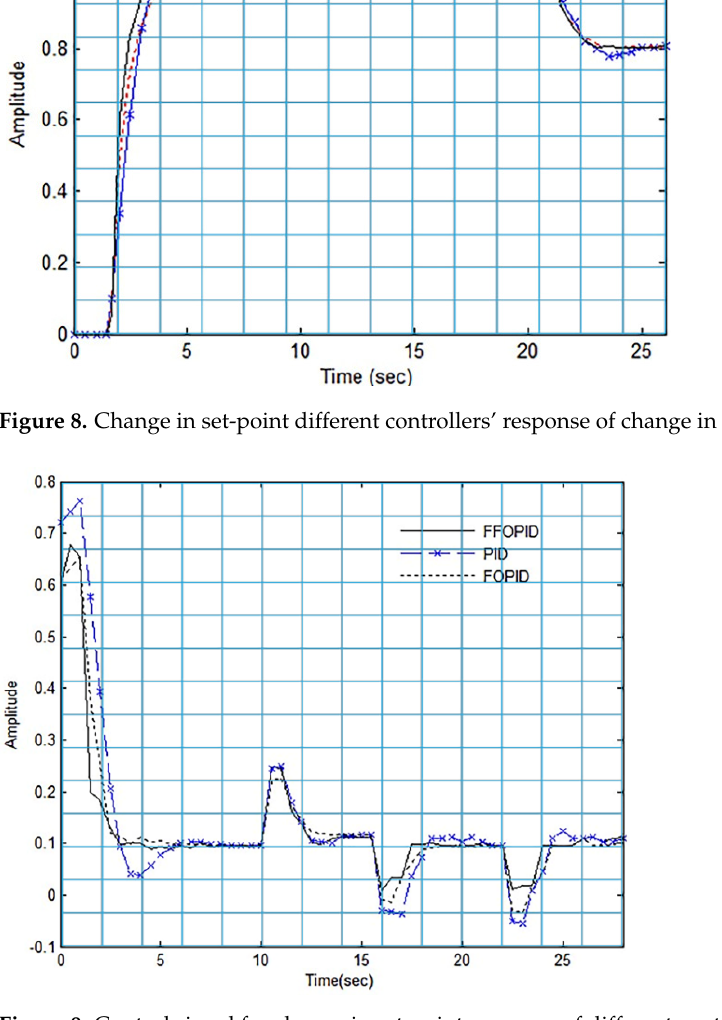
Figure 9. Control signal for change in set-point response of different controllers. Table 3. Controllers’ performance summary.